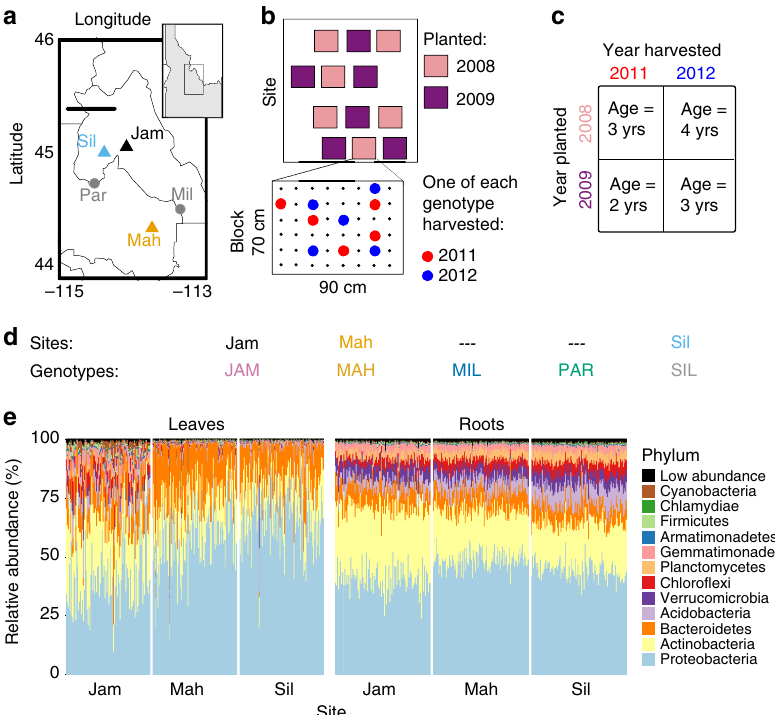
Figure 1 | Summary of experimental design and analysis. ( a ) Map of the study region in central Idaho, USA (map data from the R package ‘maps’ 70 ). The five genotypes used in this experiment were collected from the five B. stricta populations shown. We collected seeds from 8–10 individual B. stricta plants from each population, for a total of 48 accessions or genetic ‘lines’. For our analyses these lines were grouped back into five ‘genotypes’ corresponding to the populations from which their ancestors were collected. The populations marked with triangles correspond to the ‘sites’ of the three common gardens where the experiment took place. Scale bar, 50km. ( b ) Schematic representation of common garden layout. Each garden contained six replicated, randomized blocks per planting cohort (2008 and 2009). Each block contained one replicate of each ‘line’, for a total of 8–10 replicates per ‘genotype’. In both 2011 and 2012, one individual of each genotype was haphazardly chosen for destructive sampling in each block. ( c ) A temporally staggered planting/harvesting design disentangled the effects of plant age and year of observation. ( d ) Abbreviations and colour codes are shown for the five genotypes and three sites featured in this study. ( e ) The relative abundances of major phyla are shown for each leaf or root